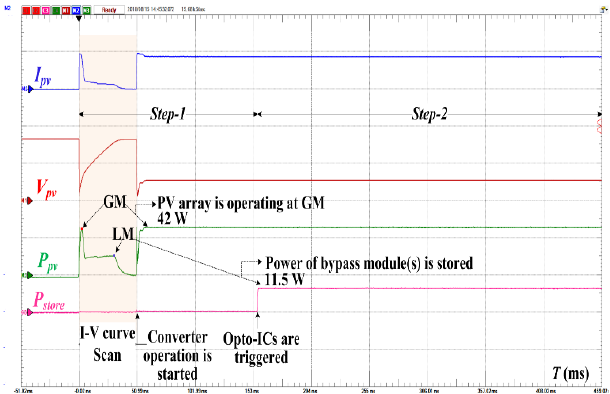
Figure 14 . Complete hardware apparatus of proposed hardware scheme along with labels .